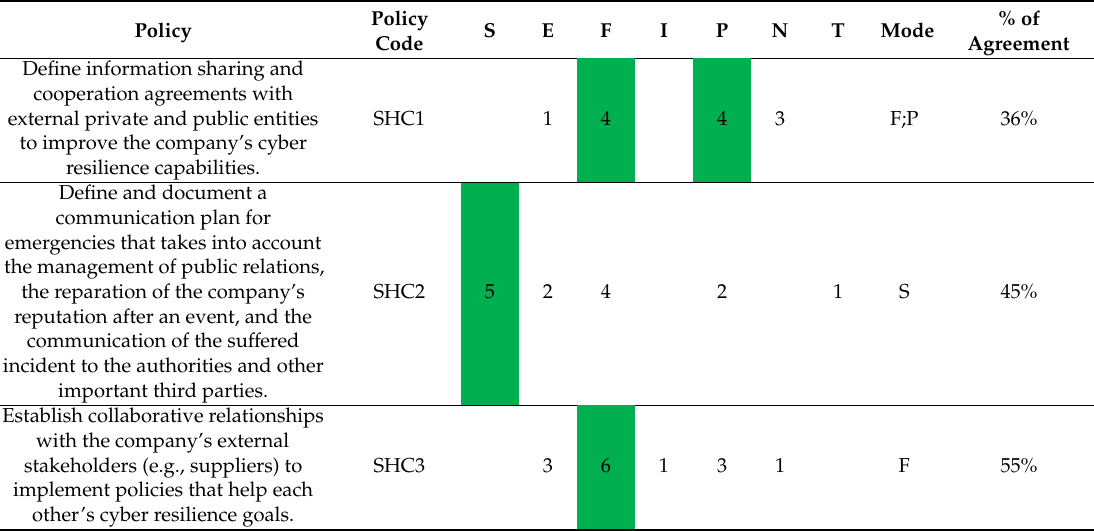
Table 30. Information sharing and communication progression